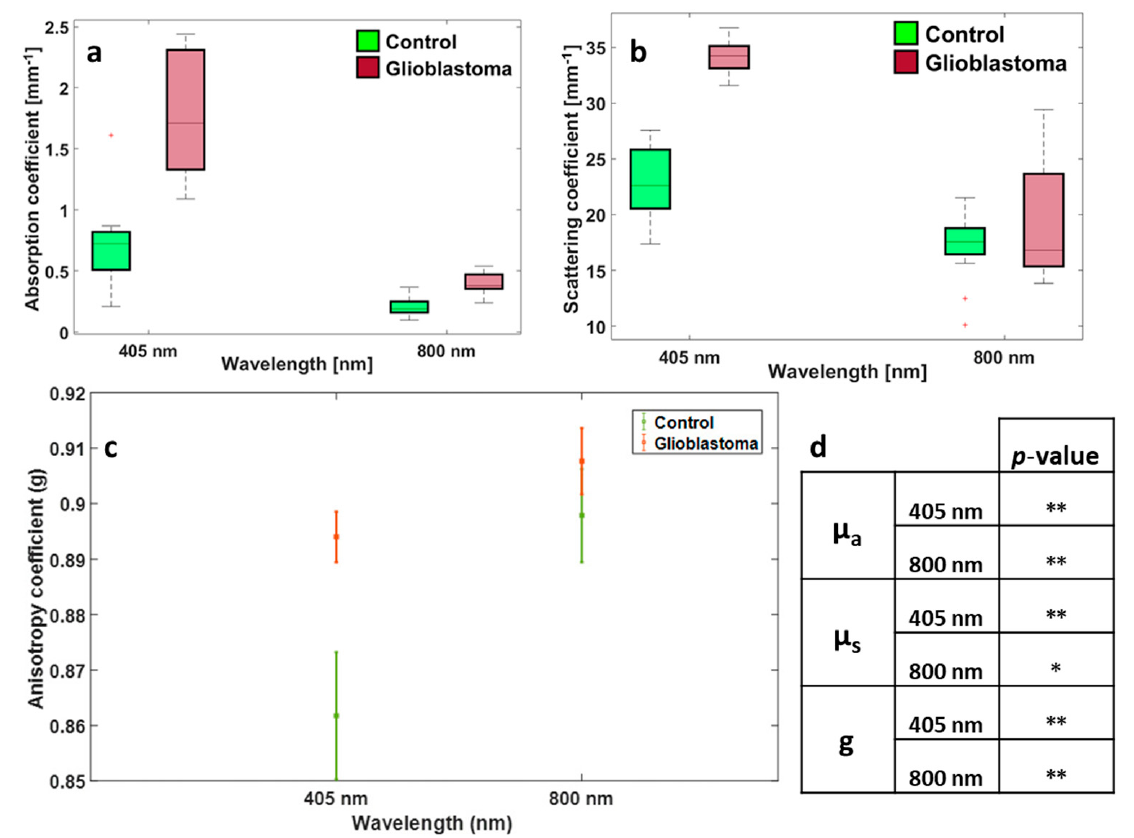
Figure 1. Distribution of absorption ( a ), scattering ( b ), and anisotropy coefficients ( c ) for the control and tumorous tissues using 405 and 800 nm excitation wavelengths, ( d ) summary table of p -values obtained by realizing a student for control vs. GBM for each parameter and for each wavelength; **: indicates that p -value < 0.05; *: indicates that p -value > 0.05.